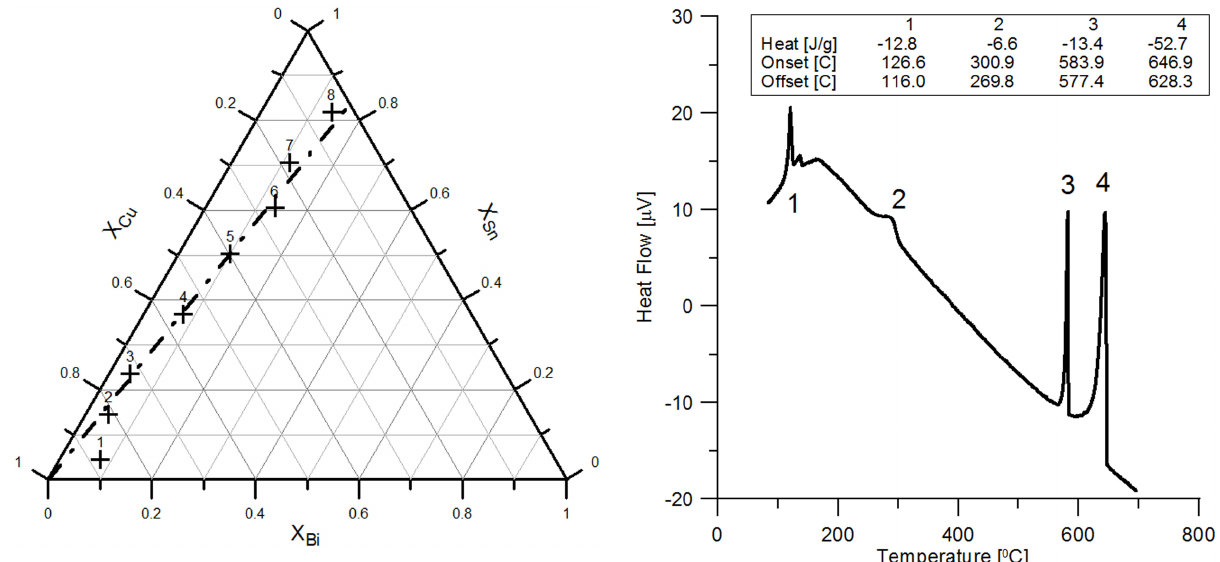
Figure 1: Chemical composition of alloys.